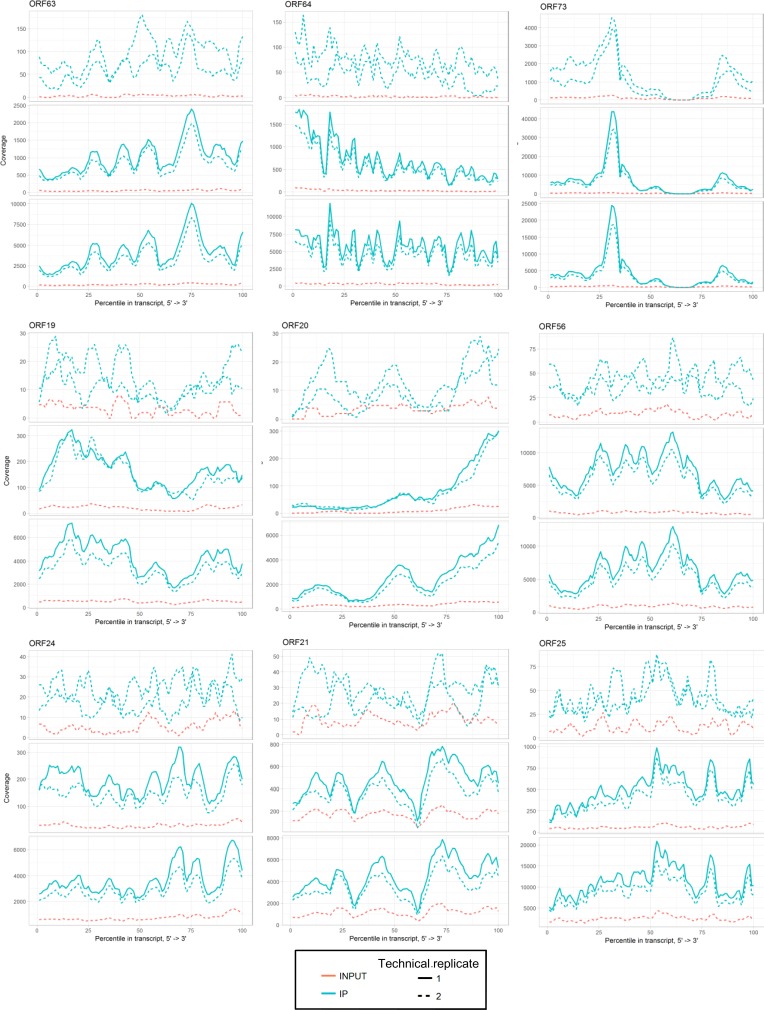
Sequencing coverage tracks for SND1 high-confidence viral RNA targets at 20 hr post-reactivation.